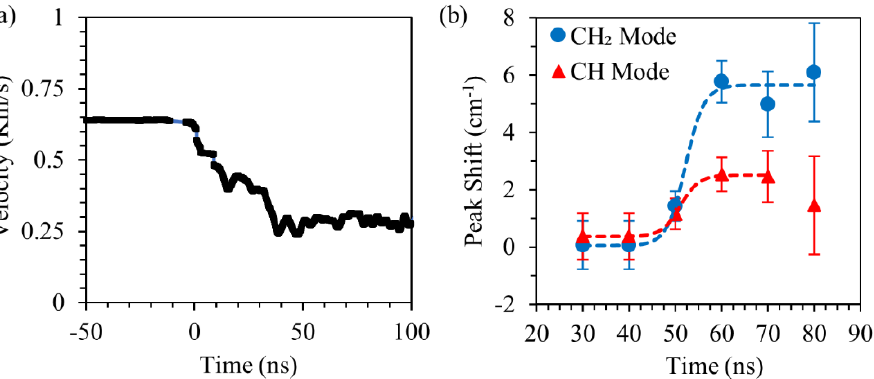
Fig. 4. (a) Velocity profile measured from the flyer through PDV (b) Time-resolved Raman spectra measured during impact